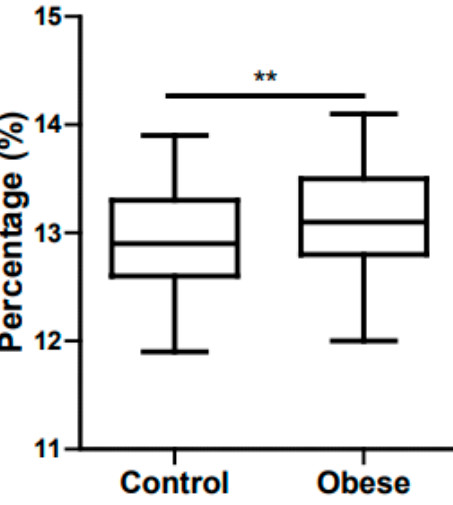
Figure 1. Volumetric dispersion of erythrocytes in pubescent controls versus obese children. ** p < 0.01.